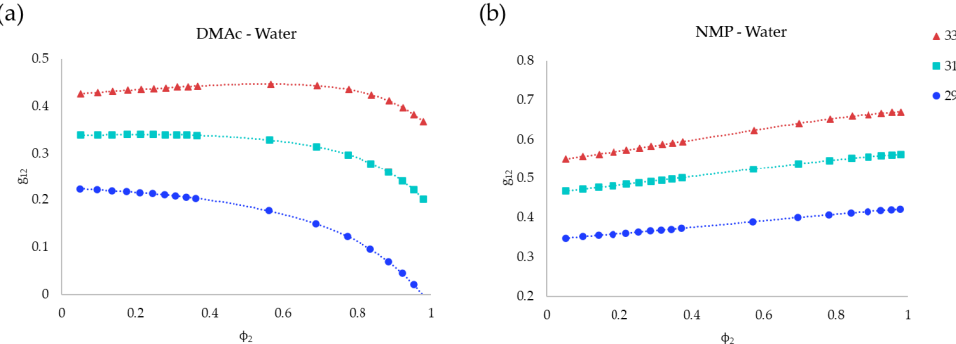
Figure 4. Influence of solvent concentration in g 12 binary interaction parameter at 293, 313 and 333 K for ( a ) DMAc–water and ( b ) NMP–water binary systems. Table 5. Coefficient of solvent/non-solvent interaction parameters for the equation g 12 ( φ 2 ) = a o + a 1 φ 2 + a 2 φ 2